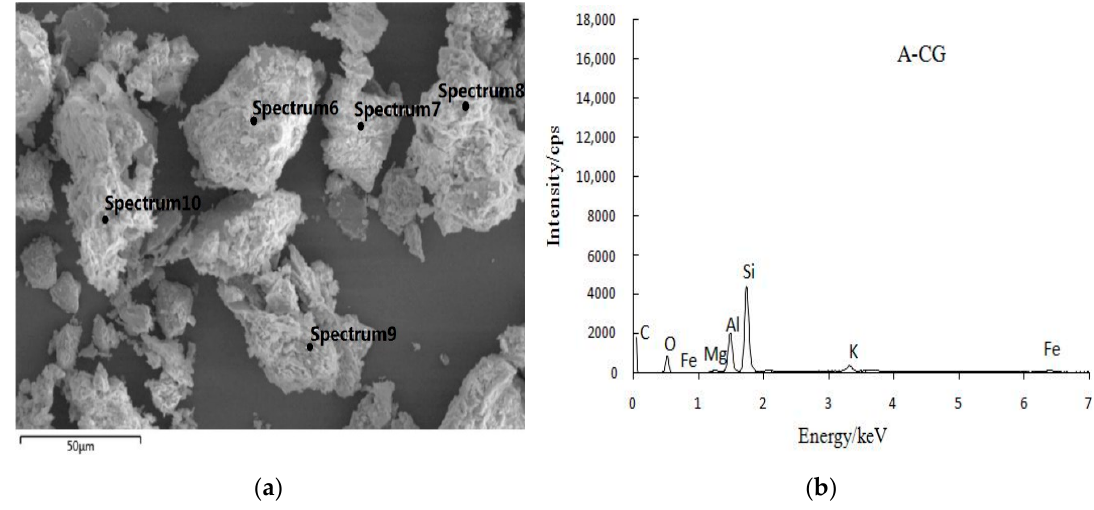
Figure 6. SEM and EDS spectrum of A-CG. ( a ) SEM Spectrum of A-CG; ( b ) EDS Spectrum of A-CG.